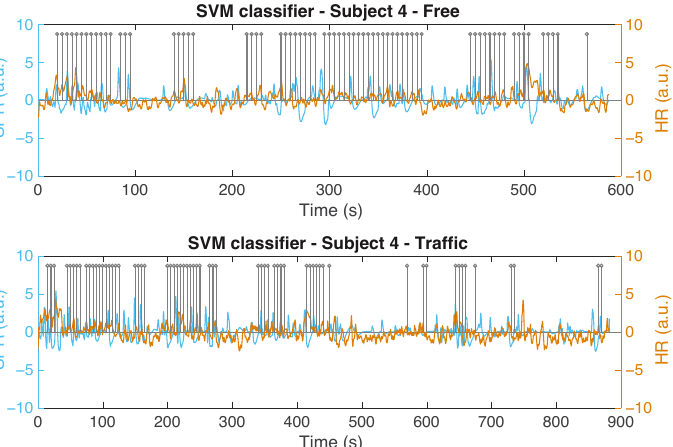
Figure 12. The output of the SVM classifier for Subject 4 in both scenarios: without traffic ( top ) and with traffic ( bottom